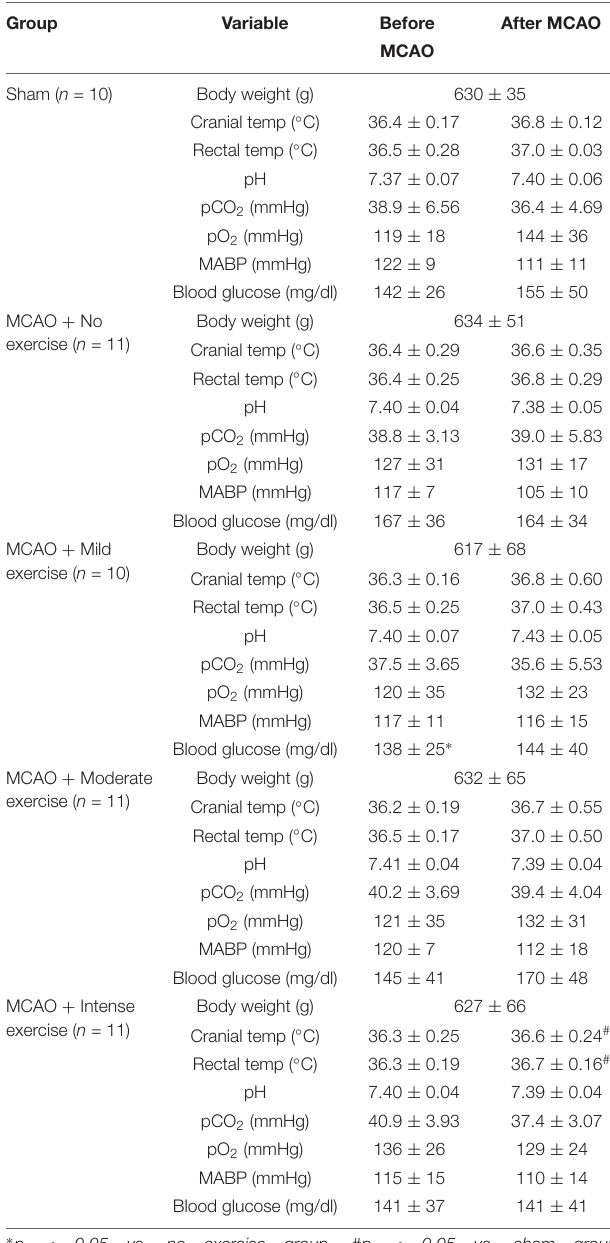
TABLE 1 | MCAO physiological parameters for male rats belonging to specific exercise and no exercise groups. Group